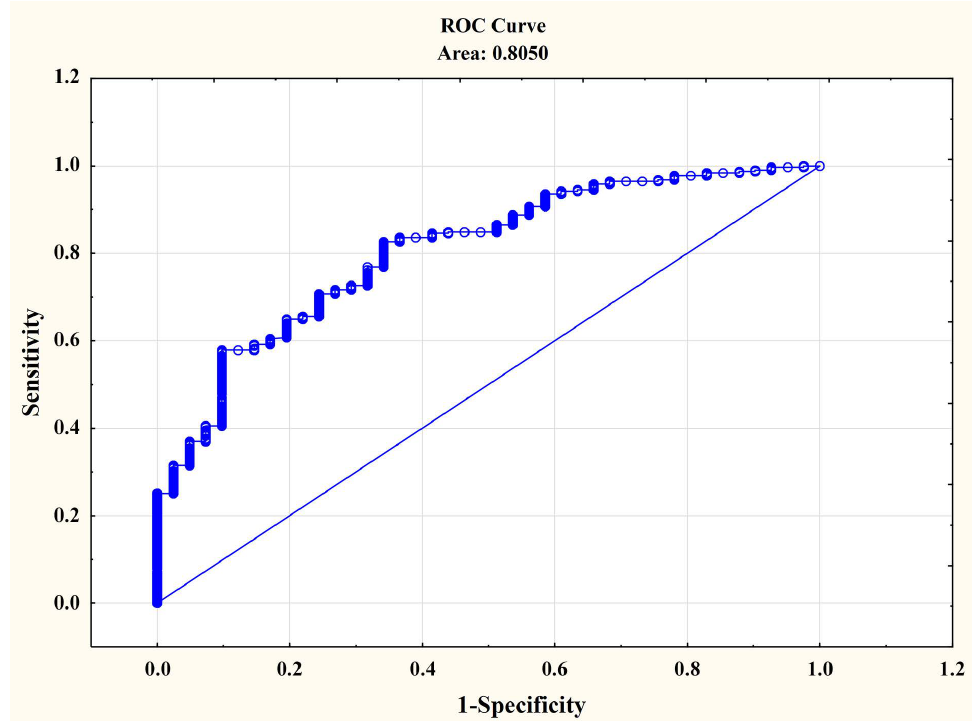
Figure 2. Goodness of Fit in the model applied based on the ROC